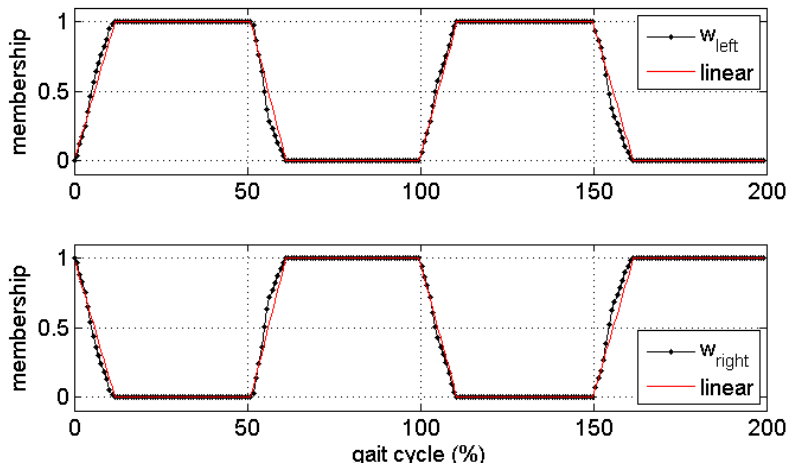
Figure 1. Approximated membership functions of the vertical ground reaction force (vGRF). The true memberships calculated with Equation (7) are shown in black dotted lines; the approximations of the membership function with gait events are shown in red lines. The upper panel shows the left membership function, which corresponds to left single support phases; the lower panel shows the right membership function corresponding to the right single support phases.